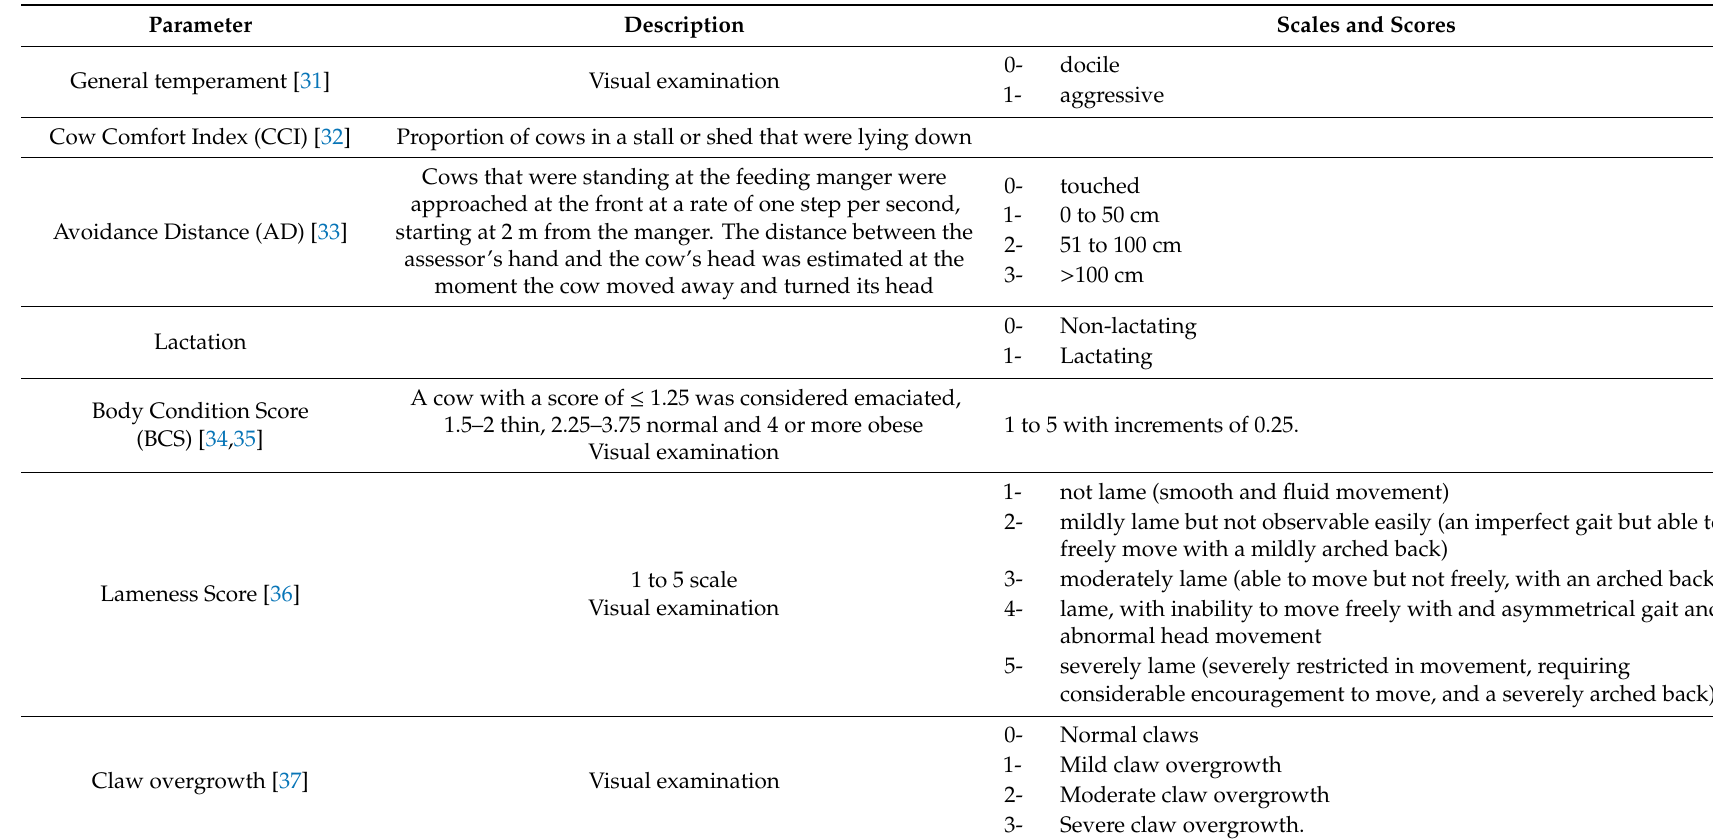
Table A1. Animal-based parameters used for the assessment of the welfare of cows in Indian